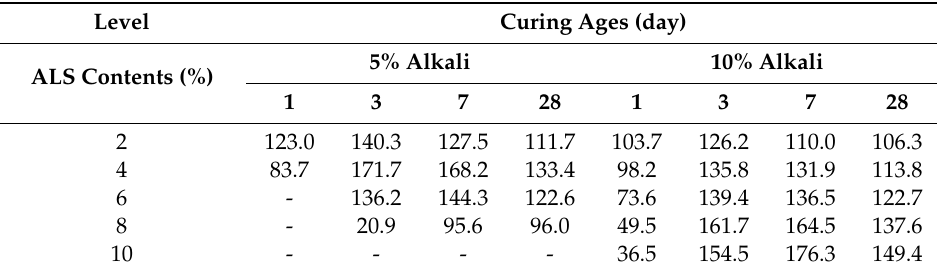
Table 2. Relative strength change rate compared with the no-ALS sample.